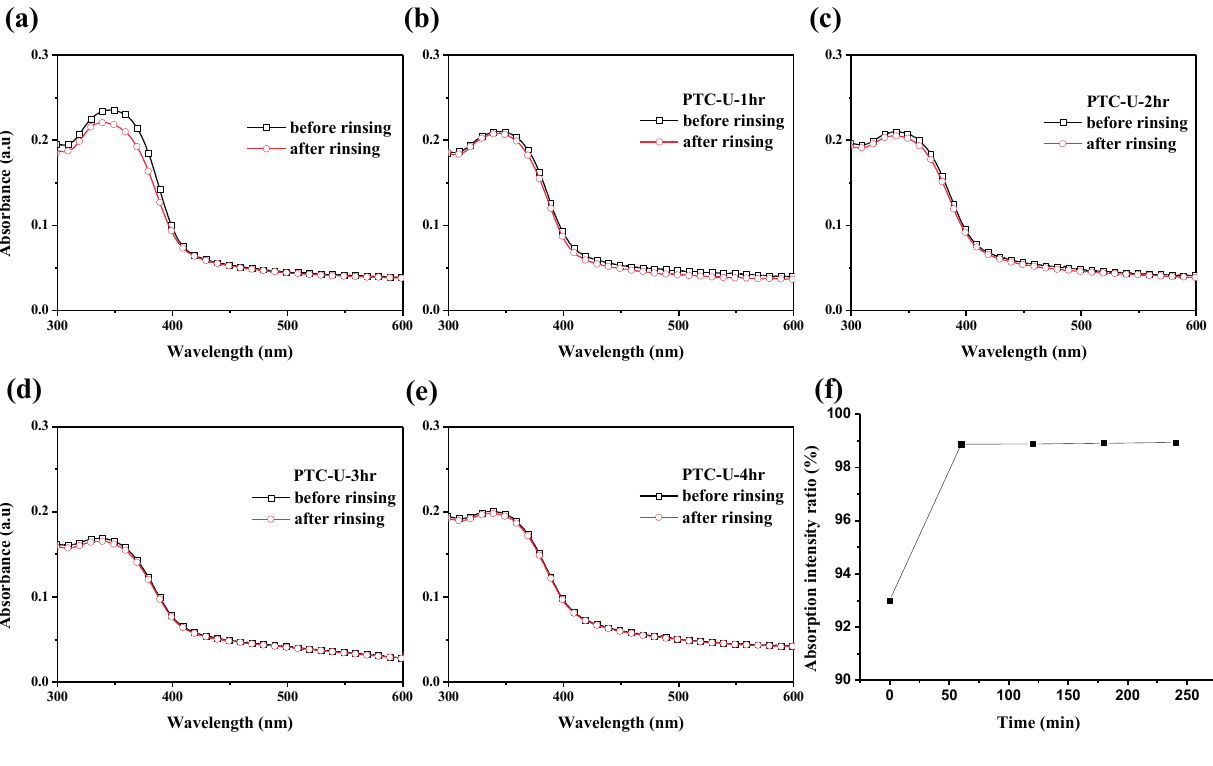
Figure 1. ( a – e ) UV-Vis spectra of PTC-U after exposure to UV irradiation for ( a ) 0 h; ( b ) 1 h; ( c ) 2 h; ( d ) 3 h; and ( e ) 4 h, both before and after rinsing with chlorobenzene ( f ) Solvent resistance (as measured by the ratio of absorption intensities before and after rinsing) plotted with respect to the UV irradiation